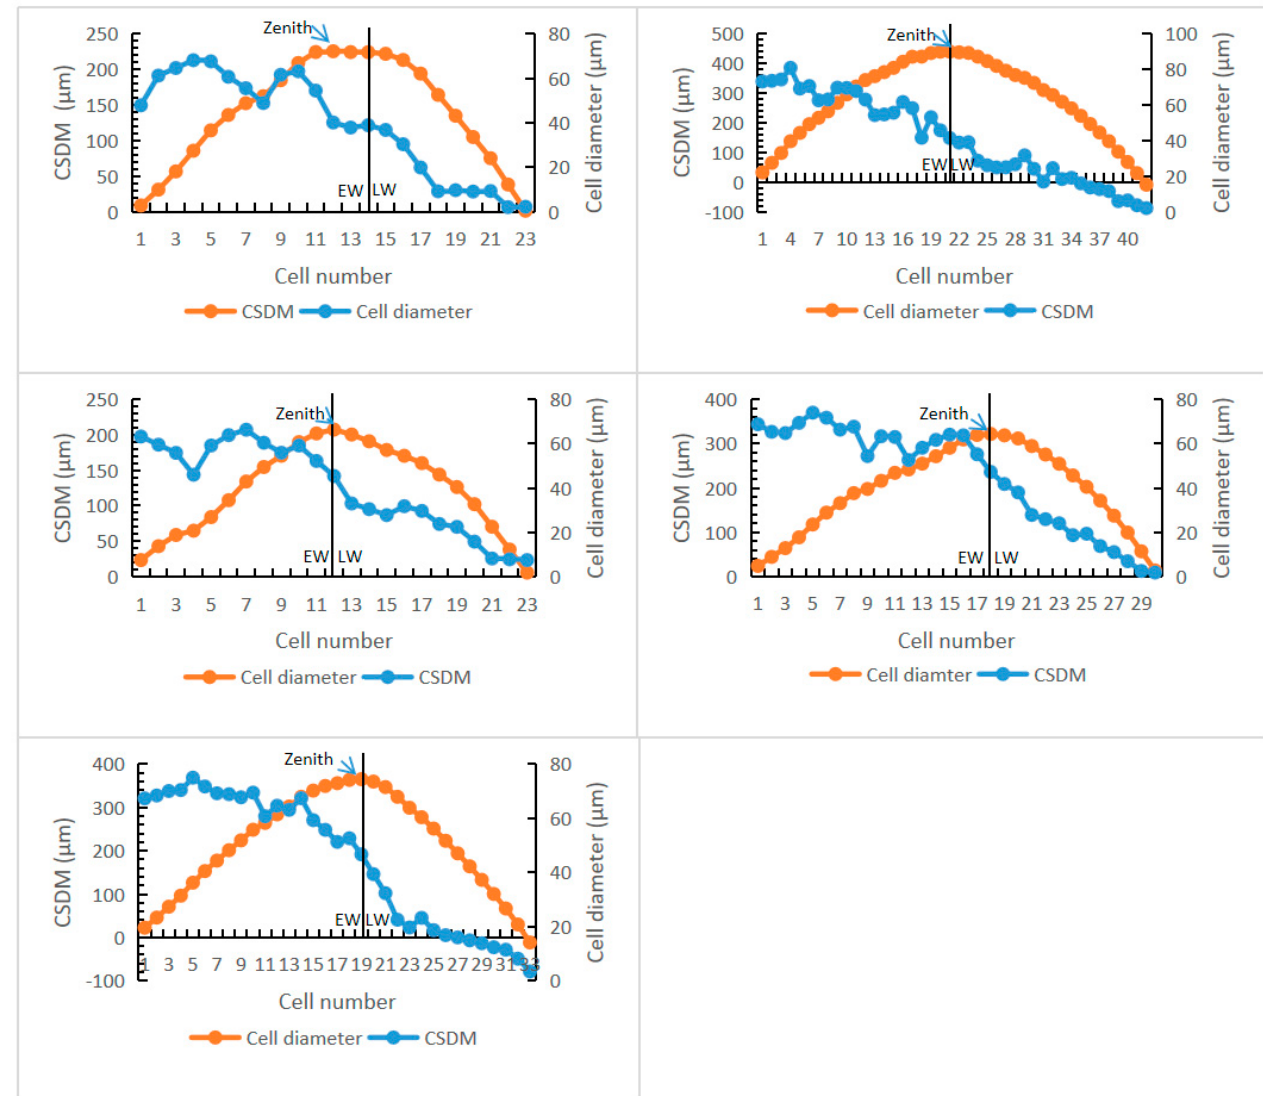
Figure 5. The CSDM curves of five growth rings and cell diameters of growth ring increment. EW: Earlywood, LW: latewood. The arrows indicate the zeniths of CSDM curves. When the abscissa value of the zenith is greater than half of the cell number, the curve is right-skewed; on the contrary, it is